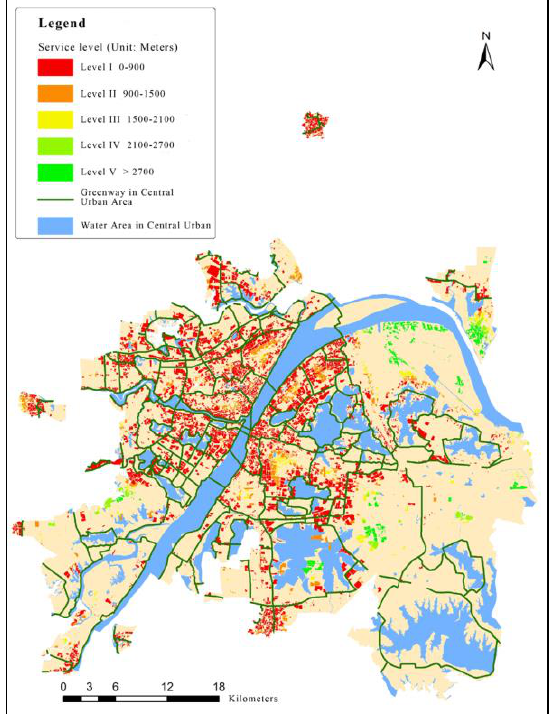
Figure 7. Distribution thematic map of the greenway accessibility level in main urban area of Wuhan.